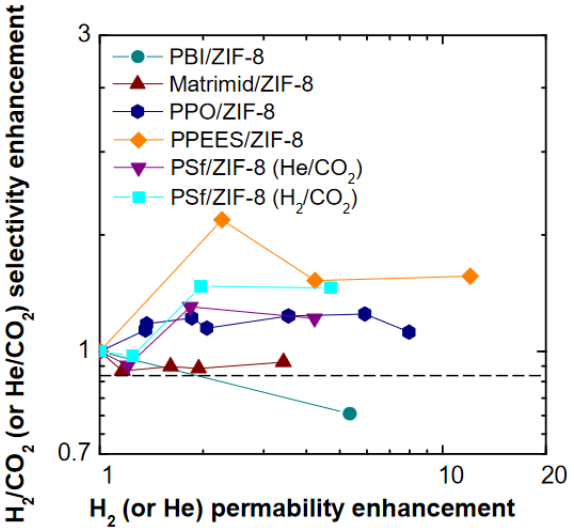
Figure 16. Comparison between He or H 2 permeability enhancement and He/CO 2 or H 2 /CO 2 selectivity enhancement after addition of ZIF-8 to various size-selective membranes: PSf (this work), Matrimid ® [21], PPEES [64], PPO [19], and PBI [22].